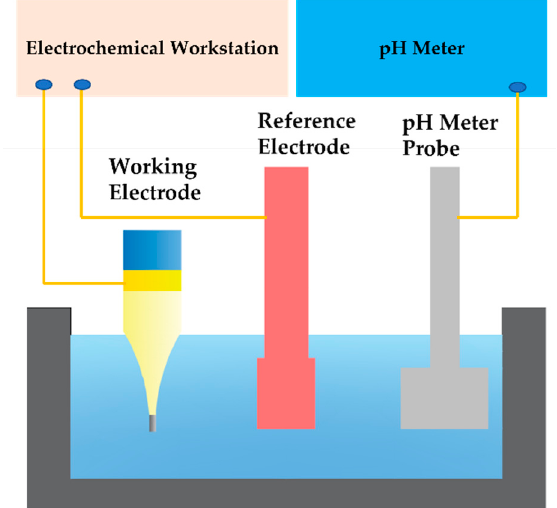
Figure 2. Schematic diagram of electrochemical